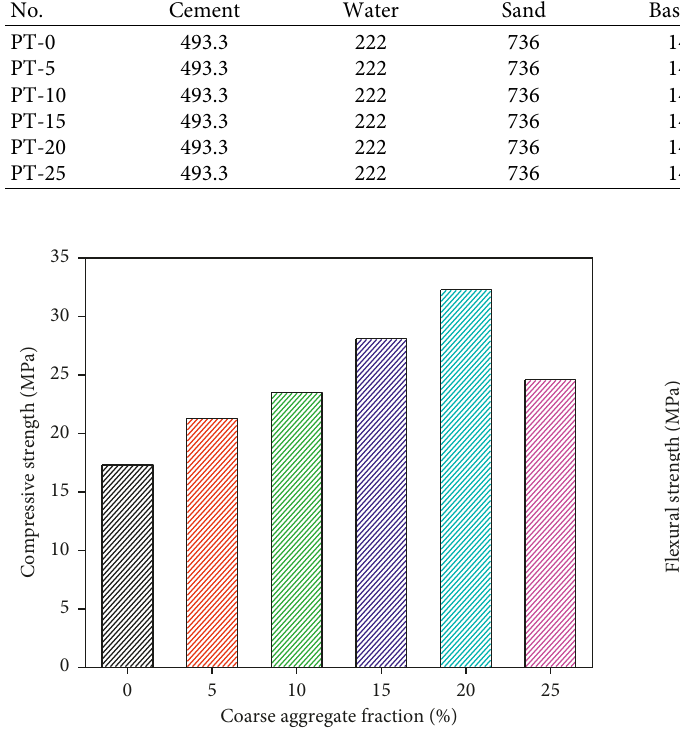
Figure 1: Compressive strength of coarse aggregate interlocking concrete subjected to different increasing amounts of coarse aggregates.